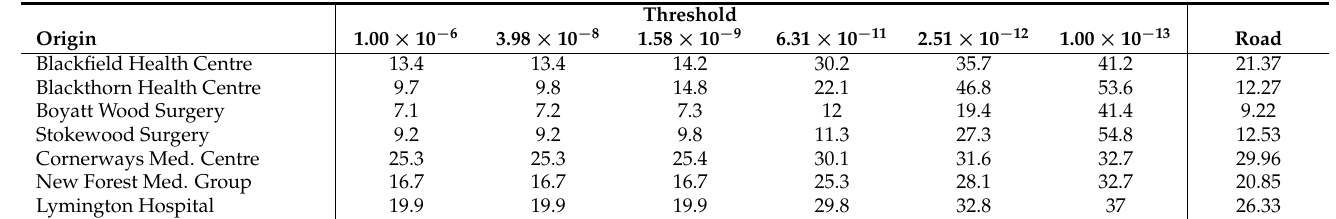
Table 4. Distance Travelled for Each Threshold/Mode. 1.00 × 10 − 6 is equal to straight-line flight in all